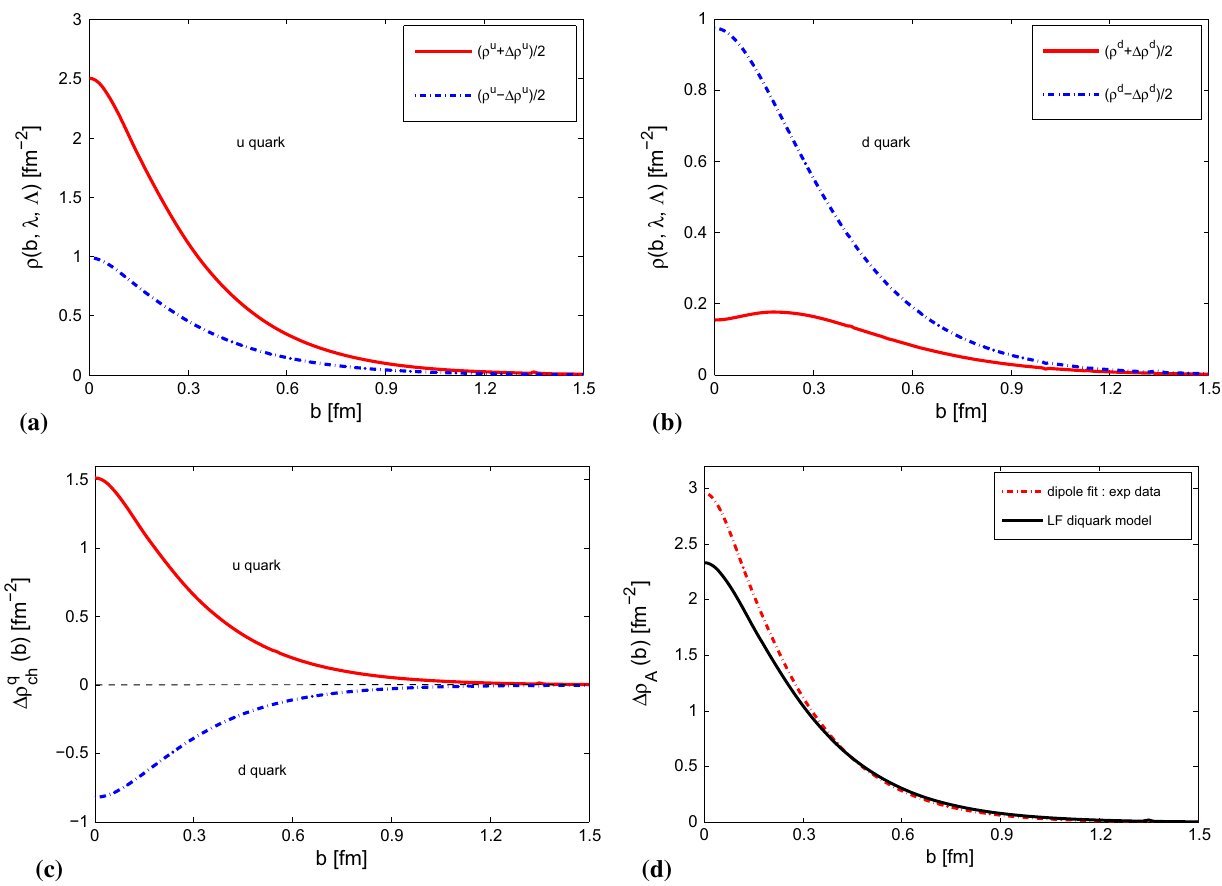
Fig. 10 (Color online) Plots of the transverse distribution of u and d quarks in a longitudinally polarized proton as a function of the impact parameter b . The total contribution for a the u quark, and b the d quark when quarks are polarized in the longitudinal direction, either parallel (solid red lines) or anti-parallel (dashed blue lines) with respect to the